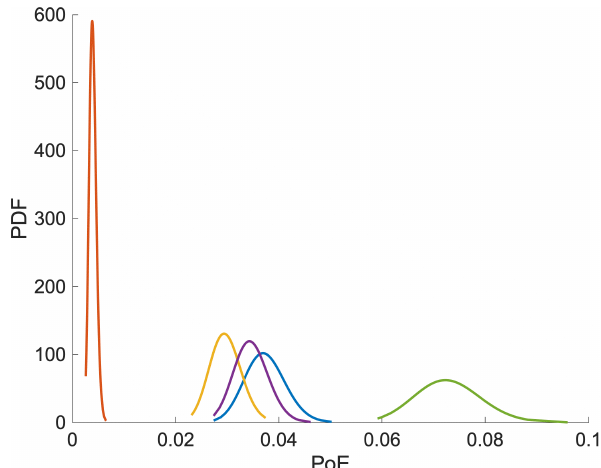
Figure 3. EED of each BET configuration relative to a tephra load threshold of 300kgm − 2 for the site in Fig.